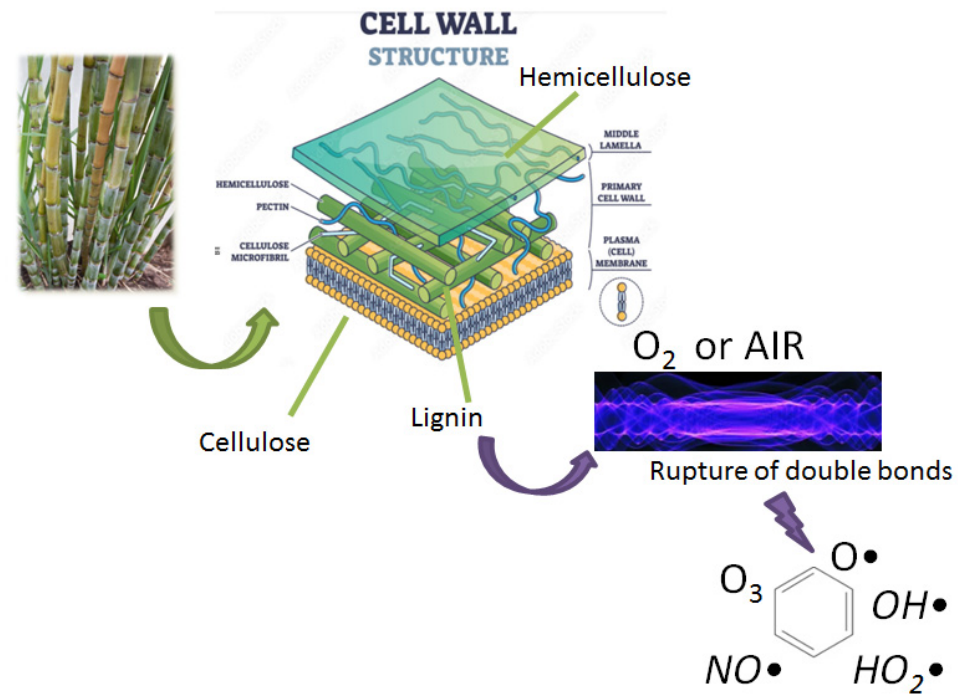
Figure 3. A possible degradation mechanism of lignocellulosic biomass using NTP.